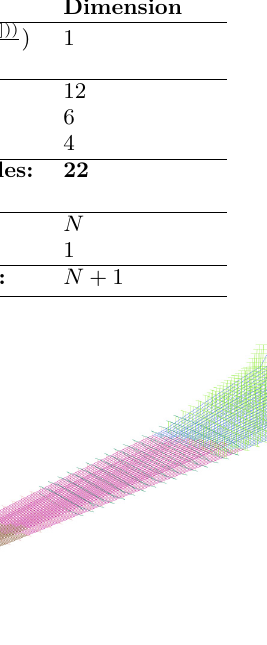
Fig. 2. Different stringer property regions for modal optimiza- tion (6 in